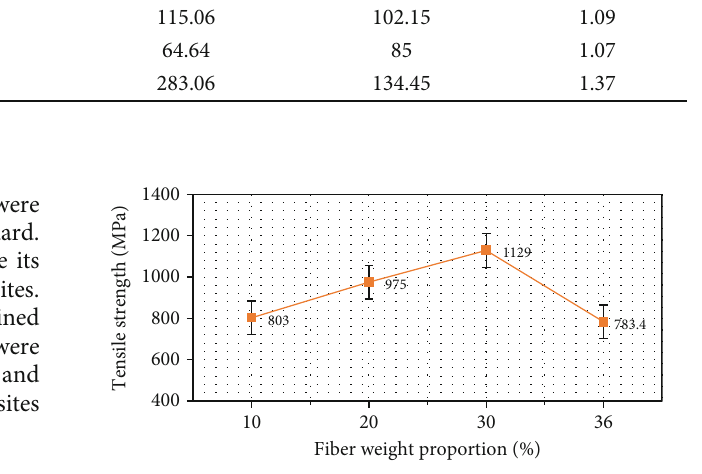
Figure 3: E ff ect of fi ber weight proportion on tensile